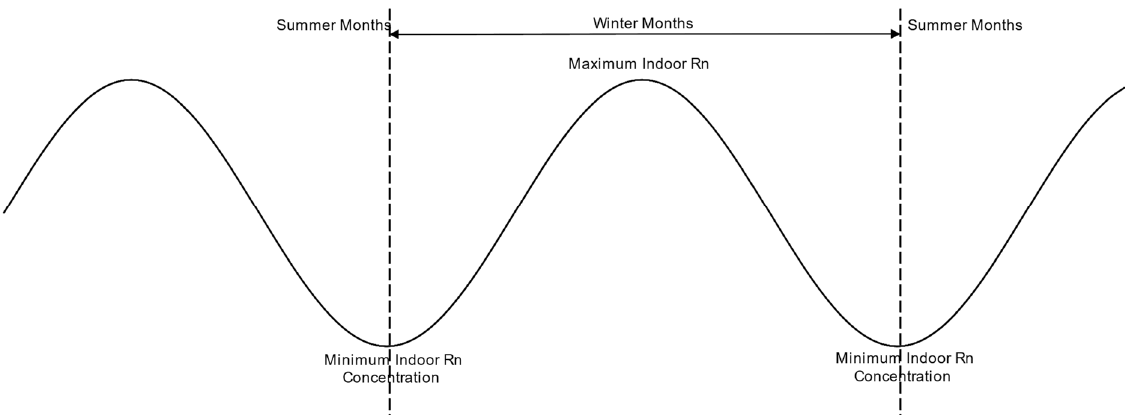
Figure 5. Schematic representation showing the evolution of the indoor Rn concentration within the twelve-month cycle.